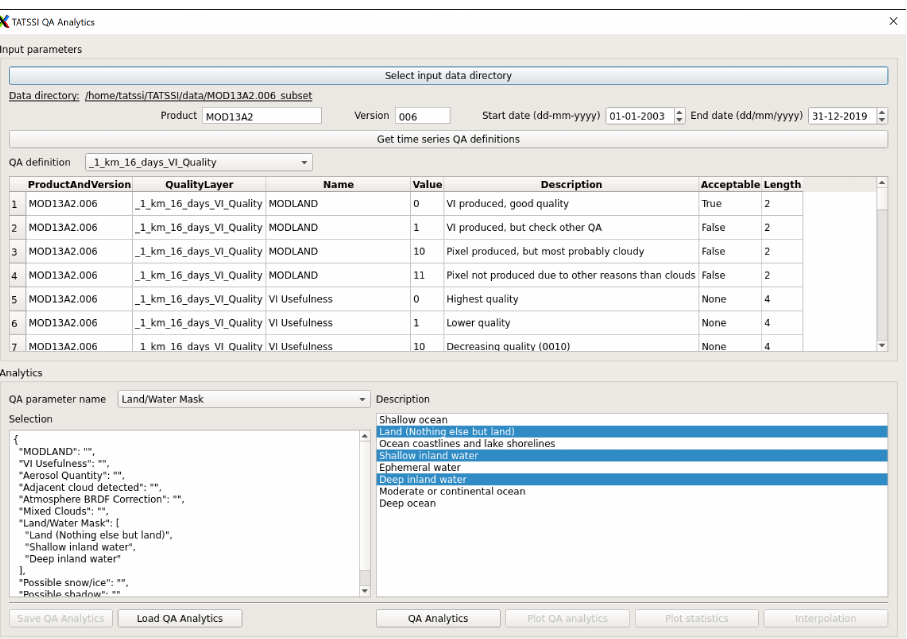
Figure 3. TATSSI QA Analytics dialog showing multiple PyQT5 objects from push buttons, lists, text and calendar boxes. This particular dialog allows the selection of QA parameters associated with a time series for a specific product and the setting of user-defined QA